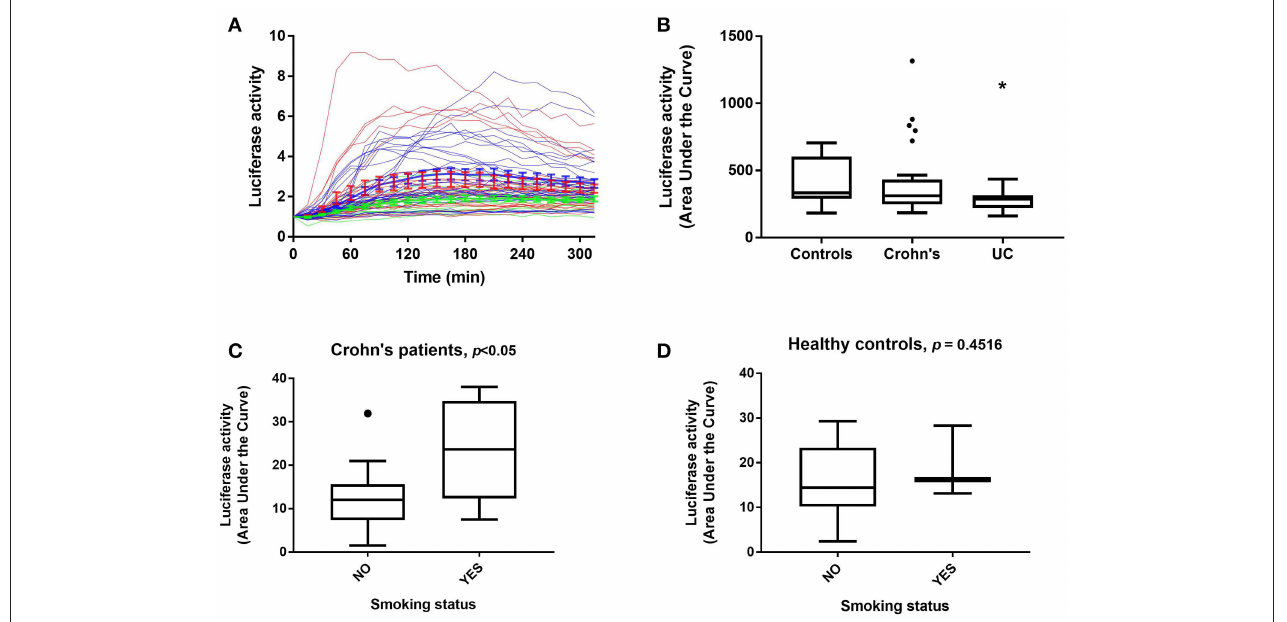
FIGURE 3 | NF- κ B-regulated luciferase activity in healthy control and IBD patient donors. Luciferase activity from all patient PBMDMs screened represented as (A) a dynamic, color-coded graph of activity over time in response to 200ng/mL LPS (blue, healthy controls; red, Crohn’s disease (CD) and green, ulcerative colitis (UC), and as (B) area under the curve (AUC) for control, CD, and UC groups. NF- κ B-regulated luciferase activity in (C) CD patients, and (D) healthy control donors based on smoking status. Statistical comparisons between disease types were made using the Kruskal-Wallis test, * p < 0.05. Statistical differences between smoking status were tested using the Mann-Whitney U -test, individual p -values are reported on each